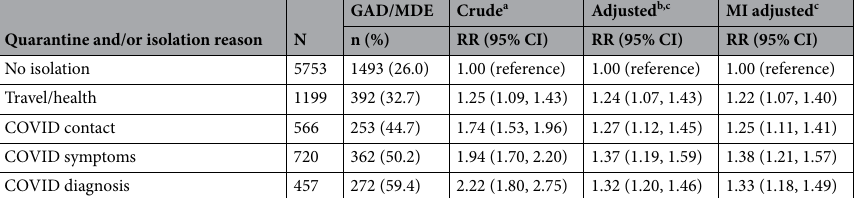
Quarantine and/or isolation reason